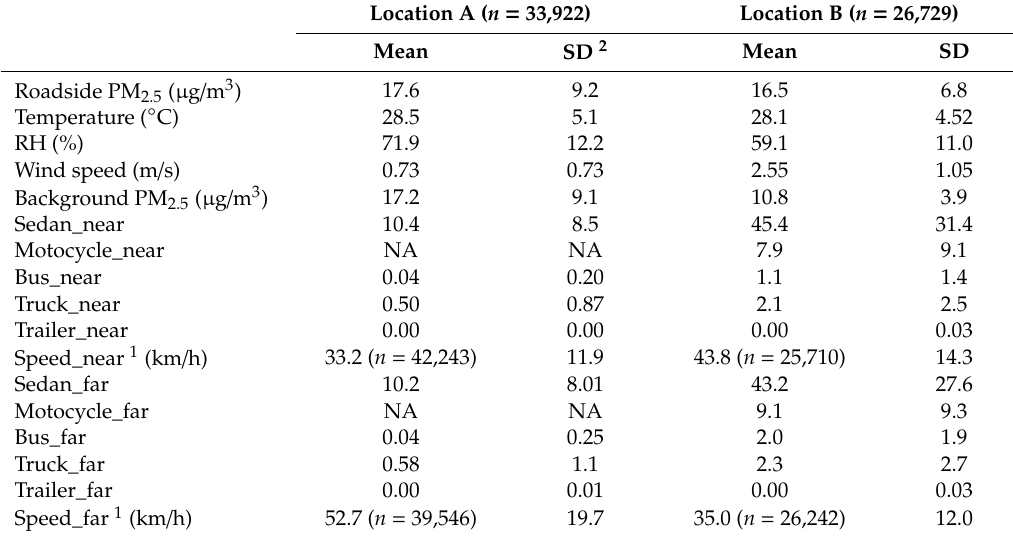
Table 2. Distribution of PM 2.5 , environmental factors, and counts of di ff erent vehicle types at two roadside monitoring locations in 5-min resolutions: “near” indicates vehicle counts and speed in the tra ffi c lines close to the AS-LUNG-O, and “far” indicates those in tra ffi c lines in the opposite directions.